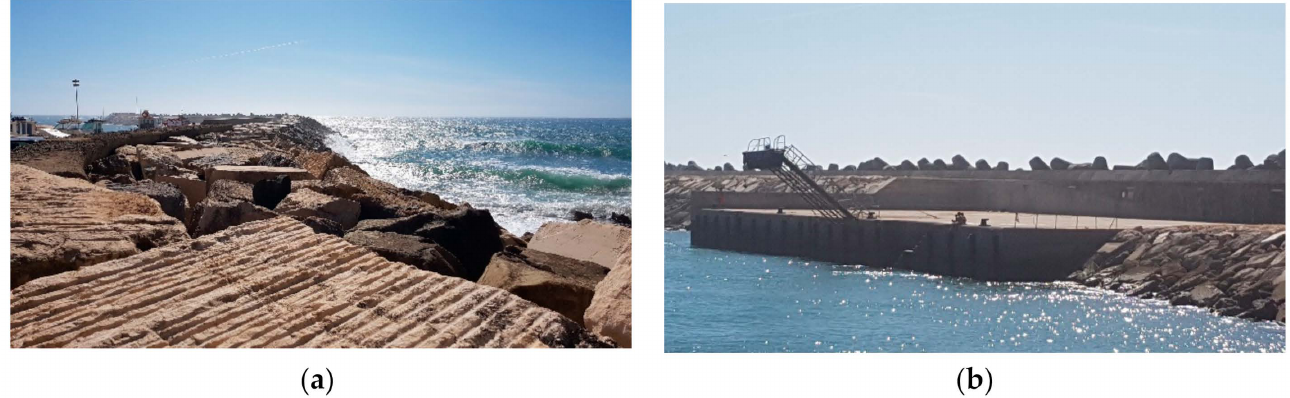
Figure 3. Cross section of the breakwater tested: ( a ) Location of the cross section on breakwater; ( b ) diagram of the cross